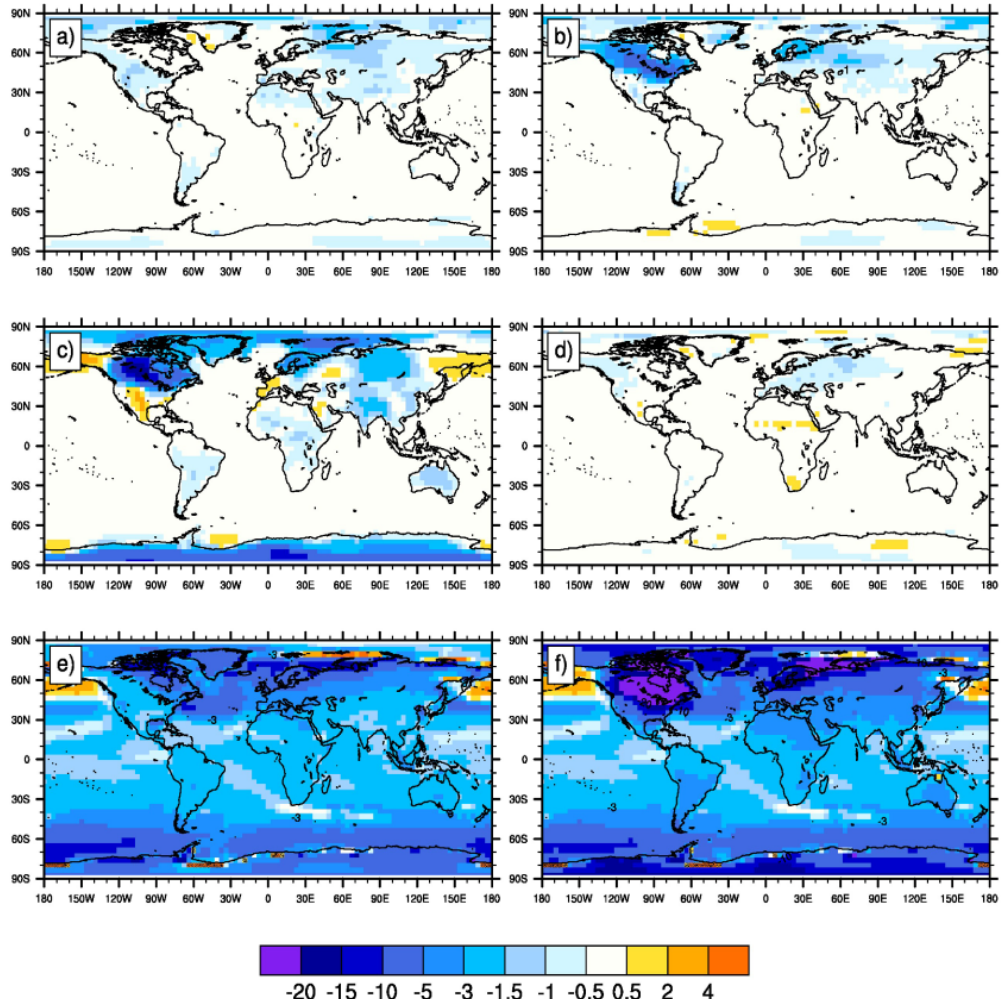
Fig. 3. Annual mean difference of surface temperature ( ◦ C) of (a) GHG, (b) albedo, (c) topography, (d) orbital, (e) SST, and (f) LGM- combined experiments from the control run. Anomalies in the surface temperature at the margins of the Ross and Weddell seas in the SST and the LGM-combined experiments are stippled because the respective grid cells were erroneously defined as ocean.